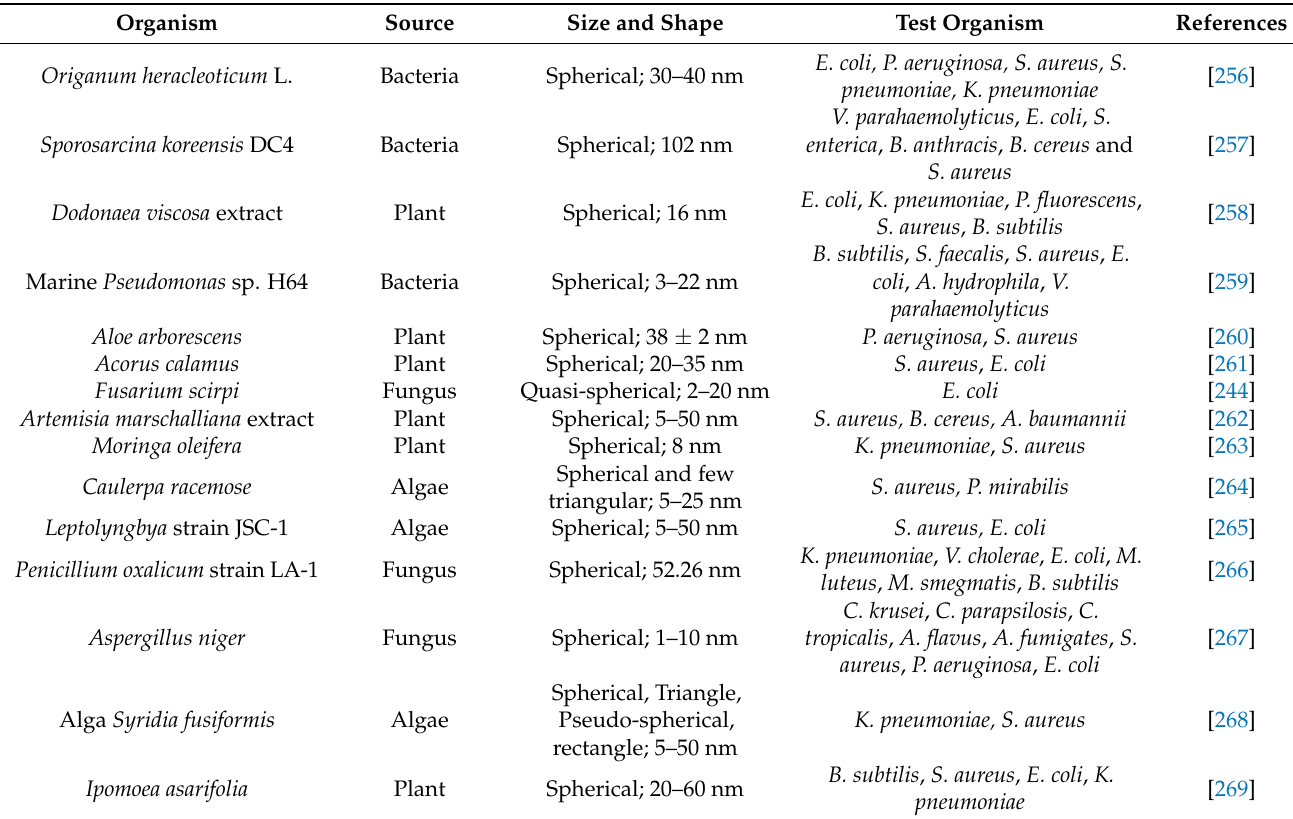
Table 3. In-vitro testing against human